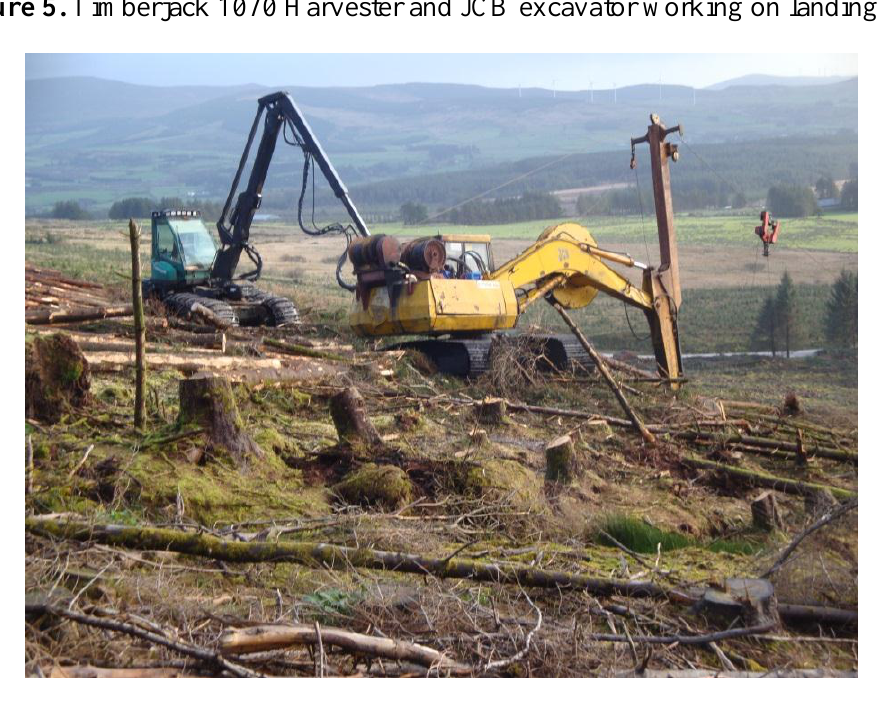
Figure 5. Timberjack 1070 Harvester and JCB excavator working on landing